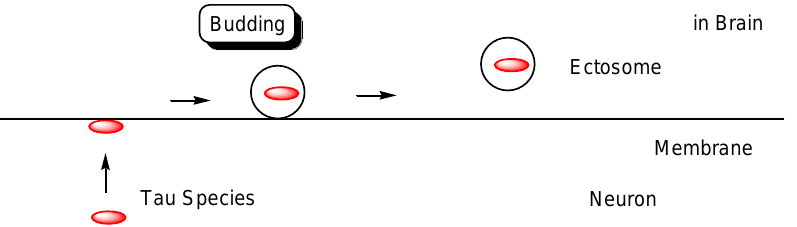
Figure 8. Tau in ectosomes (50 – 1000 nm in diameter) secreted from the membrane of neurons, independently on the endolysosomal machinery.